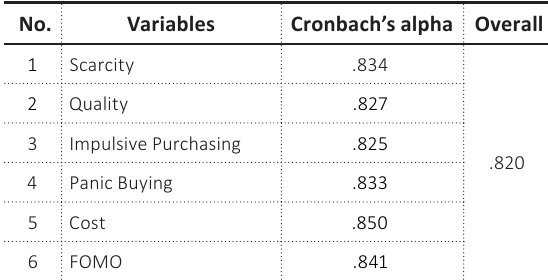
Table 3. Reliability Table 4. Summary of hypotheses